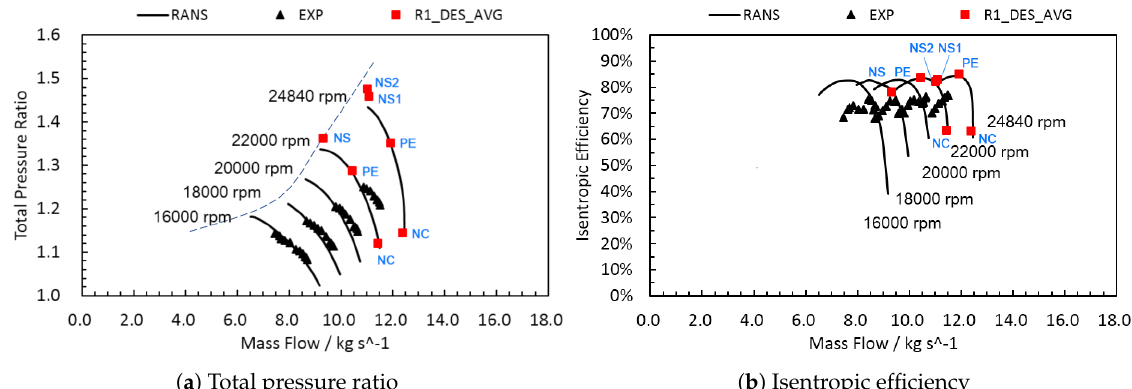
Figure 5. Comparison of overall